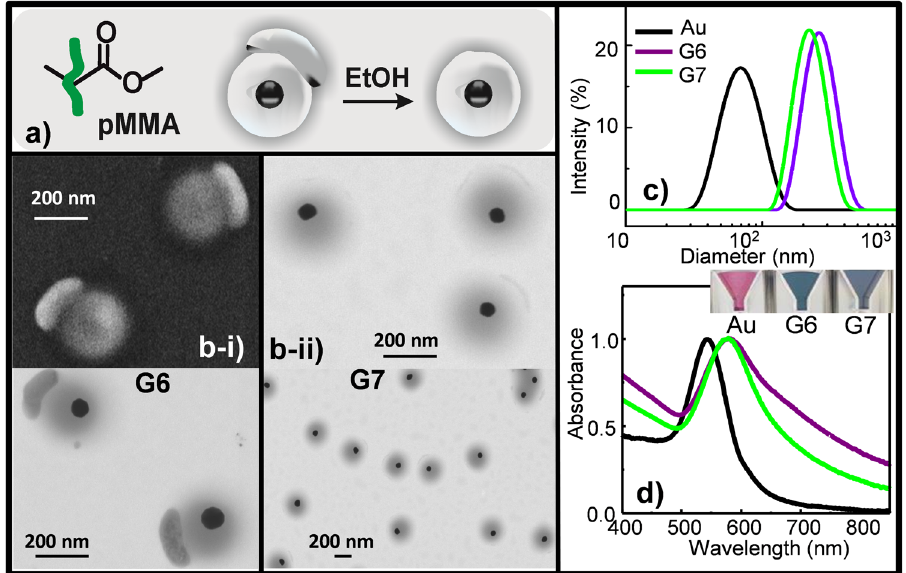
Figure 3. ( a ) Scheme of the monomer mediated in situ growth strategy for the core-shell Au@pMMA nanohybrids synthesis; ( b ) S-TEM images of nanohybrids obtained in different H 2 O/EtOH concentration ratio: ( b - i ) G6 and ( b - ii ) G7, both at high and low magnification. SEM image of G6 is reproduced in left-top of ( b - i ); ( c ) Size diameter by intensity distribution and ( d ) UV-Vis absorption of the nanostructures. Inset: color variation of the Au@pMMA nanohybrid solutions with the shell-morphology changes.